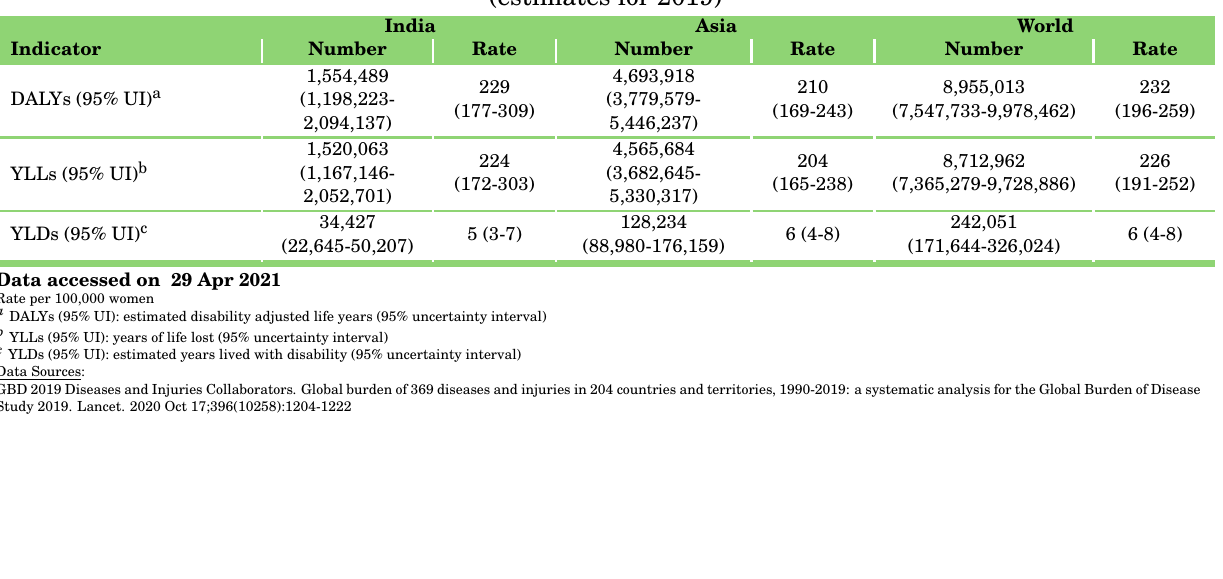
Table 6: Premature deaths and disability from cervical cancer in India, Asia and the rest of the world (estimates for 2019)